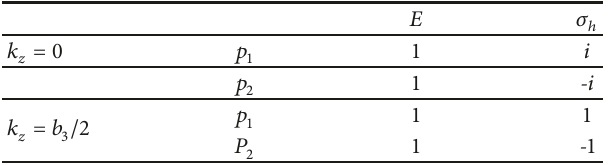
Table 7: Possible IRs of pair in symmetry directions in BZ for 𝐷 6ℎ group in strong spin-orbit coupling